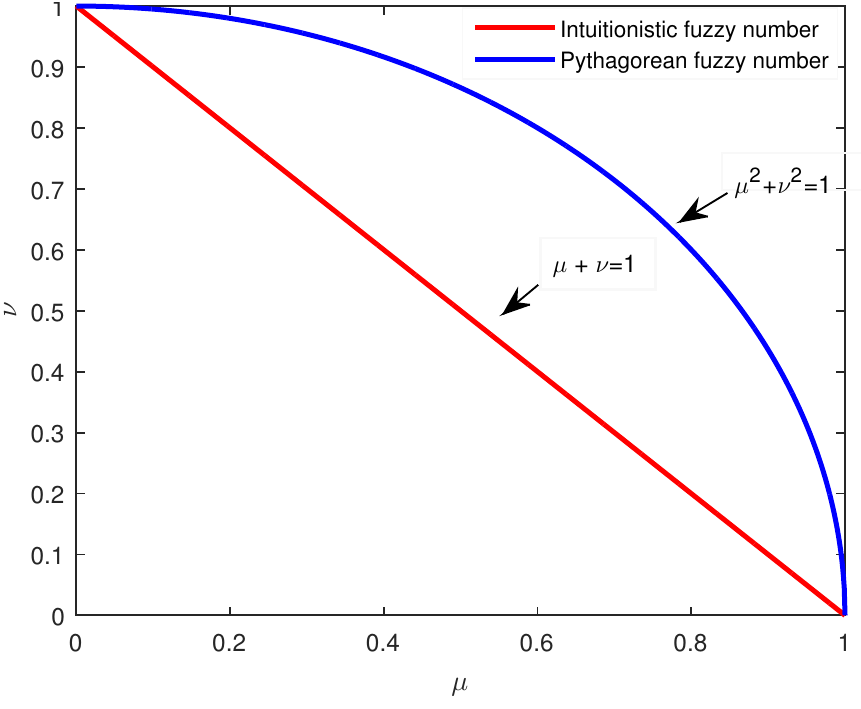
Figure 1. Comparison of spaces of the IFN and the